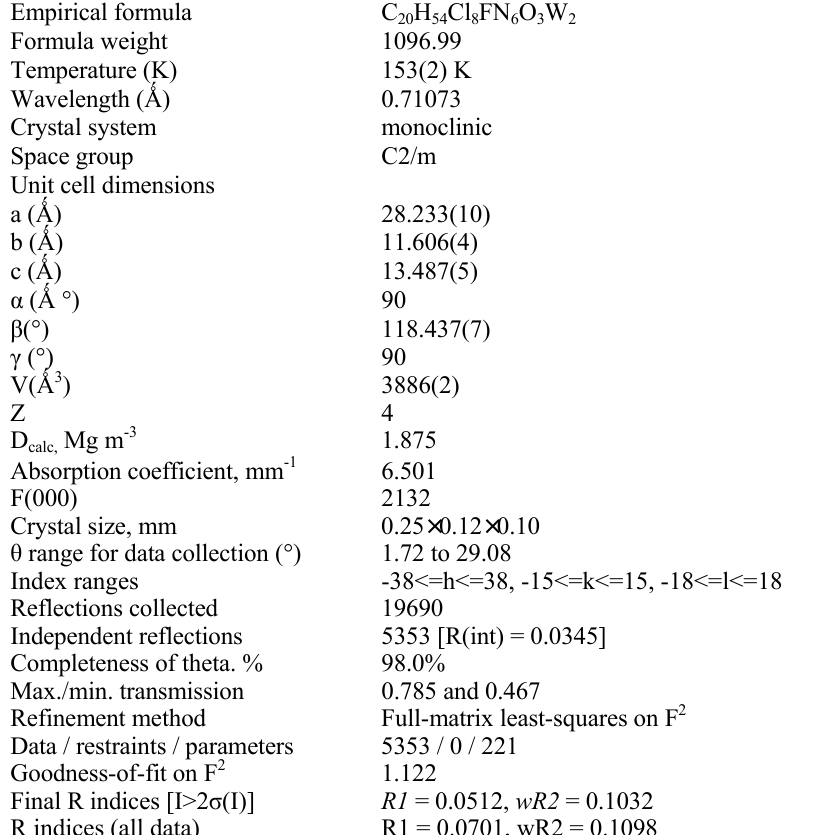
Table 1. Crystal data and structure refinement for the complex